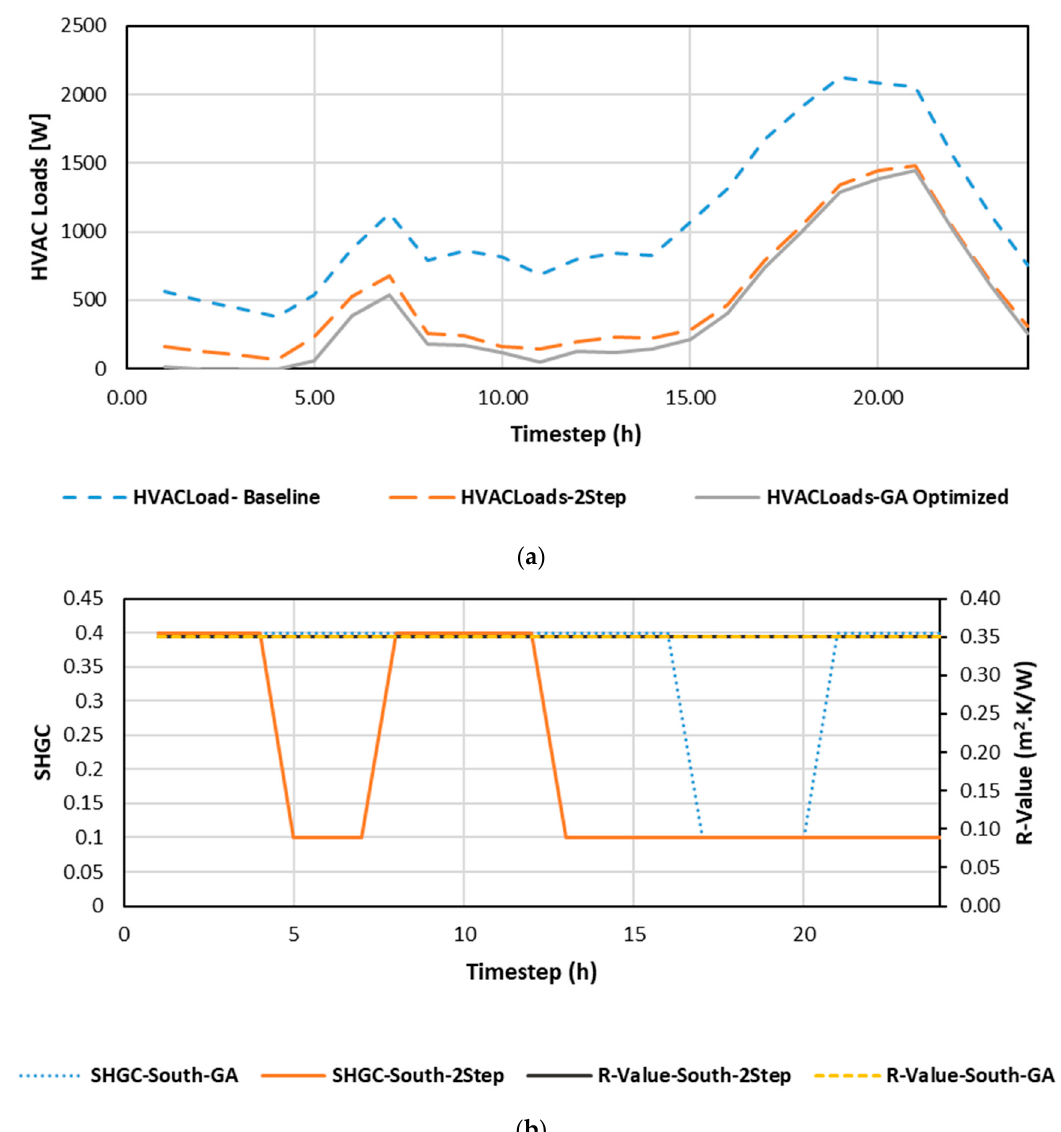
Figure 10. Hourly variations of ( a ) R-values and SHGC settings, and ( b ) thermal loads for an STIS–smart window with southern exposure during a summer day (July 13) for a dwelling located in San Francisco, CA, USA.